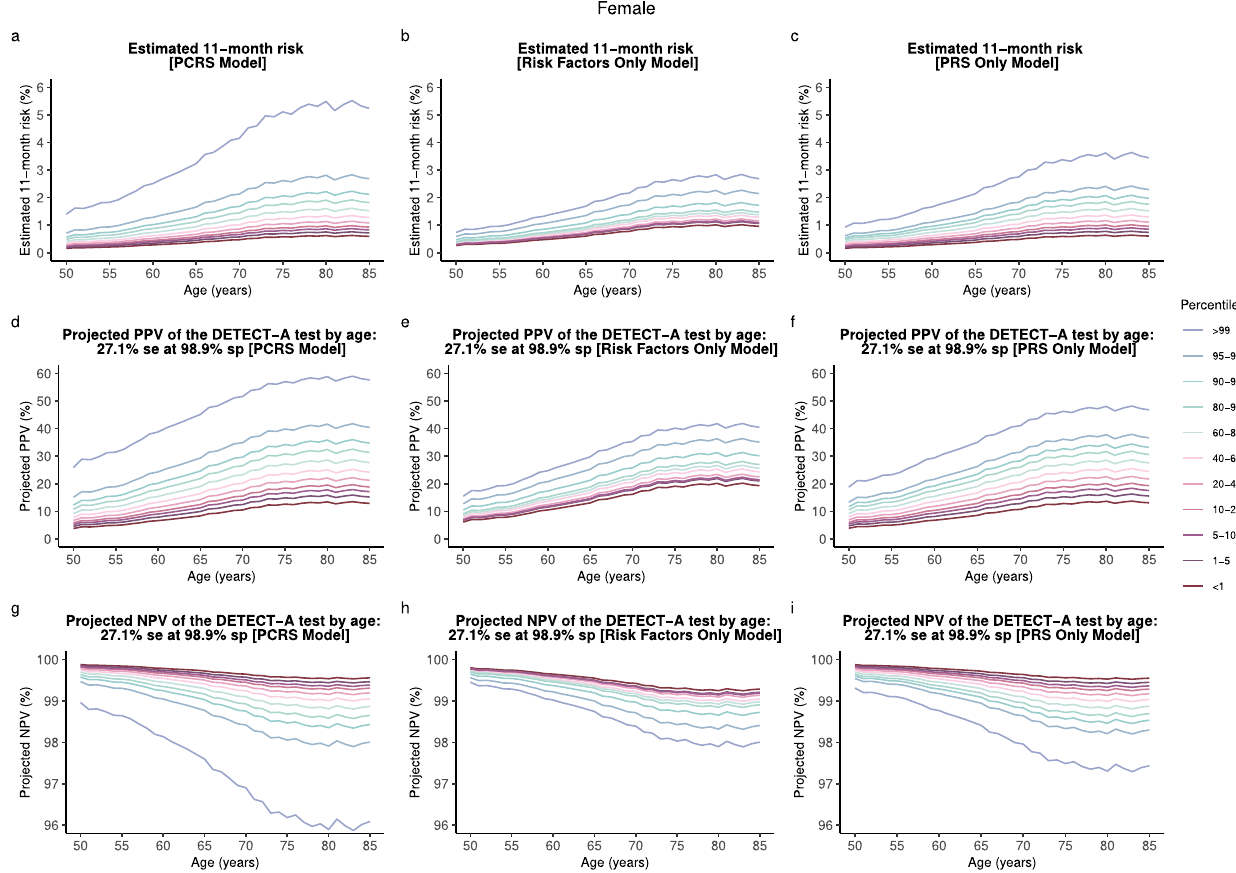
Fig. 2 Comparison of the estimated absolute risk and the projected PPV and NPV of the DETECT-A test for three separate models (PCRS, Risk factors only, and PRS only). a – c Estimated 1-year absolute risk of developing one of the ten cancer types for the three separate multicancer risk prediction models. d – f Projected PPV of the DETECT-A test (27.1% sensitivity at 98.9% speci fi city) for three separate multicancer risk models. g – i Projected NPV of the DETECT-A test for three separate multicancer risk models. The pan-cancer risk score (PCRS) model uses cancer-speci fi c PRSs and conventional risk factors (BMI, smoking status, pack-years of smoking, and family history of cancer in fi rst- degree relatives) shared across multiple cancer type as covariates. Risk factors only model includes conventional risk factors as predictors. PRS only model includes the cancer-speci fi c polygenic risk scores for bladder, breast, colorectum, endometrium, kidney, lung, melanoma, non- Hodgkin ’ s lymphoma (NHL), ovary, and pancreas as covariates. se sensitivity, sp speci fi